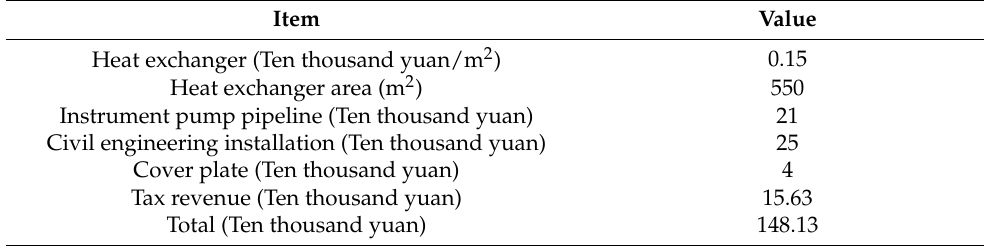
Table 4. The cost parameters of flue gas desulfurization-waste heat recovery